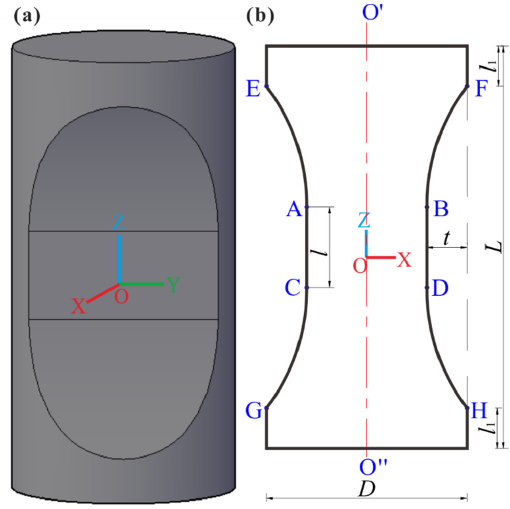
Figure 1. Schematic diagram of the new flattened cylinder specimen ( a ) stereogram ( b ) sectional view of yoz plane.